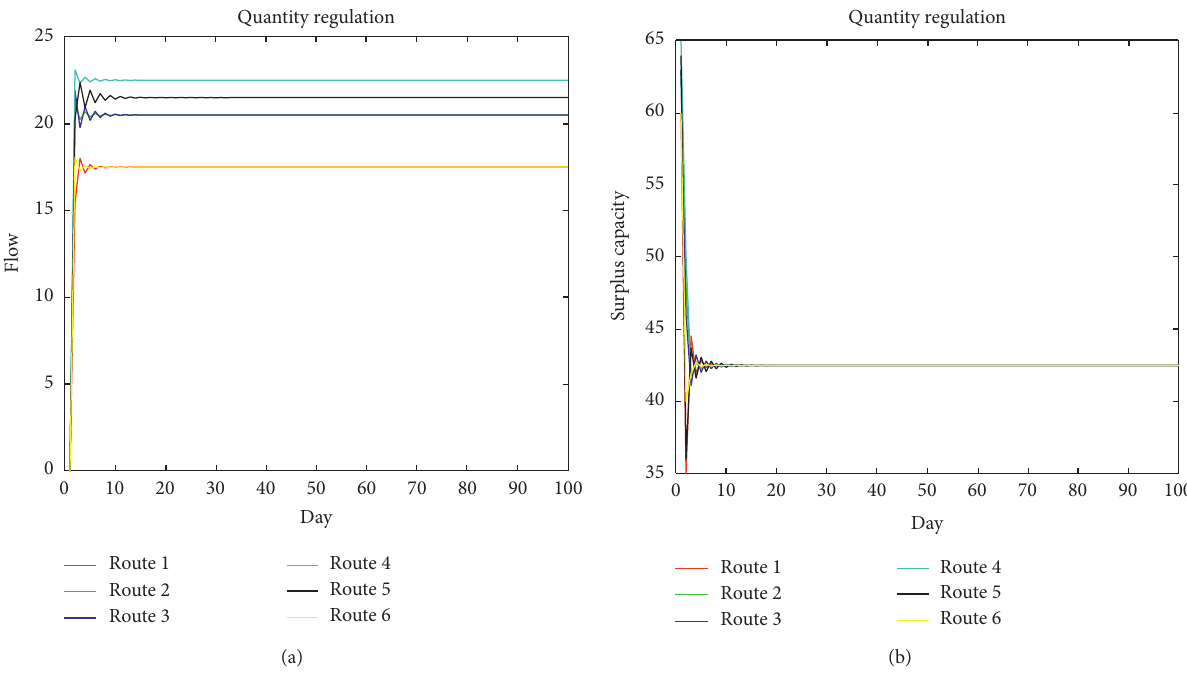
Figure 3: Evolutionary trajectories of route flows (a) and route surplus capacity (b) for travellers in the second